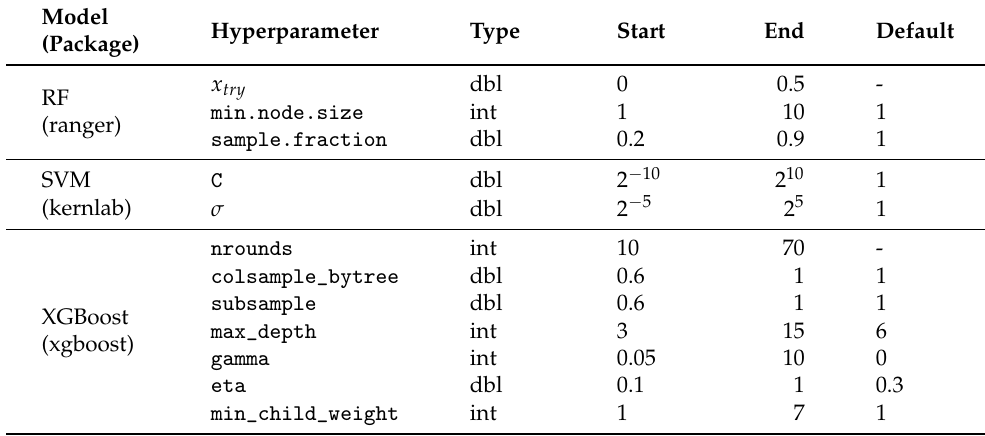
Table A1. Hyperparameter ranges and types for each model. Hyperparameter notations from the